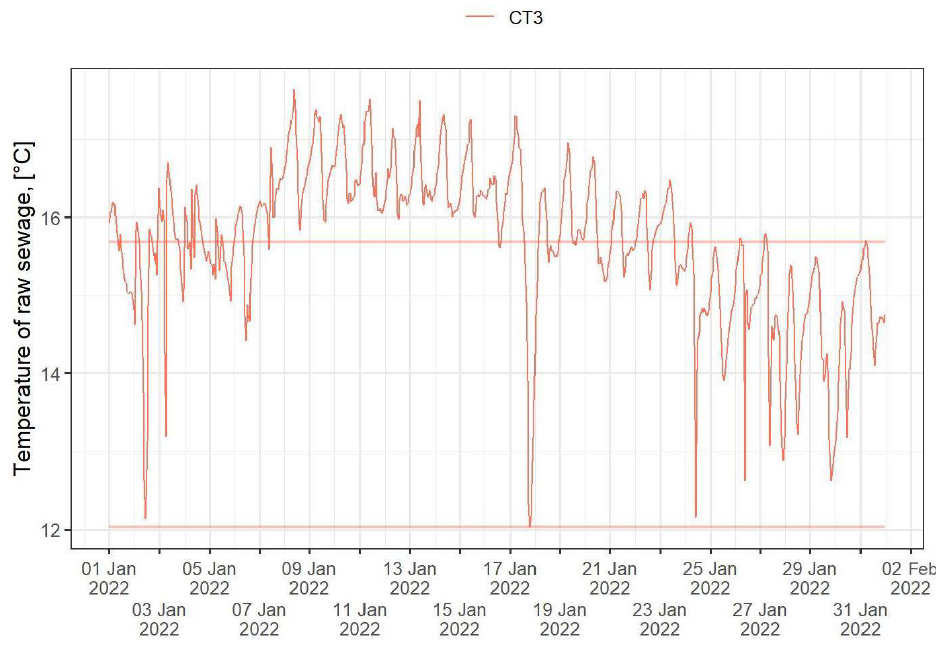
Figure 3. Average hourly raw sewage temperature values in the technological line CT 3 for the selected month with the marked minimum and average values.